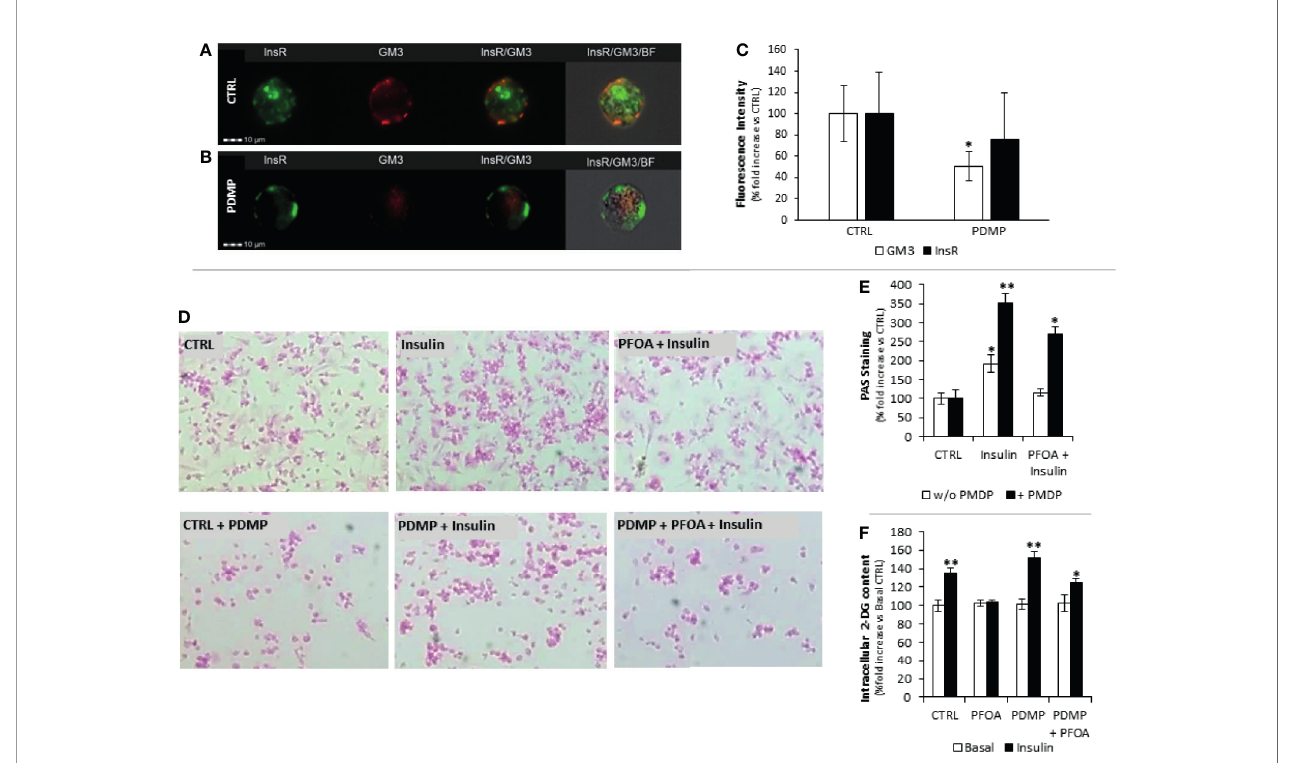
FIGURE 4 | Staining pattern of Insulin Receptor (InsR, green) and GM3 ganglioside (GM3, red) in HepG2 at basal (CTRL, A ) and after 96 hours treatment with (±)-threo-1-Phenyl-2-decanoylamino-3-morpholino-1-propanol hydrochloride (PDMP, B ) 20 ng/mL at Flow Cytometry Imaging analysis. In (C) the evaluation of the fl uorescence intensity is reported as percentage fold increase compared to control. Data report the mean value of three independent experiments. Signi fi cance: *P < 0.05 vs CTRL. (D) Representative images of Periodic Acid Schiff (PAS) staining in HepG2 cells, in basal condition (CTRL) and after stimulation with 100 nm insulin (Ins), exposed for 24h to per fl uoro-octanoic acid (PFOA) at the concentration of 0 ng/mL (CTRL) and eventually treated for 96 hours with PDMP. The histogram plot in (E) shows the corresponding results of image analysis on PAS staining intensity. Data are reported as the percentage fold increase compared to the corresponding control condition, in which both PFOA and Ins were omitted, and represent the mean value of three independent experiments. Signi fi cance: *P < 0,05 and **P < 0,01 respectively vs corresponding control. (F) Evaluation of glucose uptake in HepG2 cells by the 2-deoxyglucose (2-DG) assay. Intracellular 2-DG was quanti fi ed in basal condition and after stimulation with 100 nm insulin, after the exposure for 24h to 1000 ng/mL PFOA and eventually treated for 96 hours with PDMP. Data are reported as the percentage fold increase compared to control condition, in which both PFOA and Ins were omitted, and represent the mean value of a quadruplicate. Signi fi cance: *P < 0,05 and **P < 0,01 respectively vs corresponding basal where Ins was